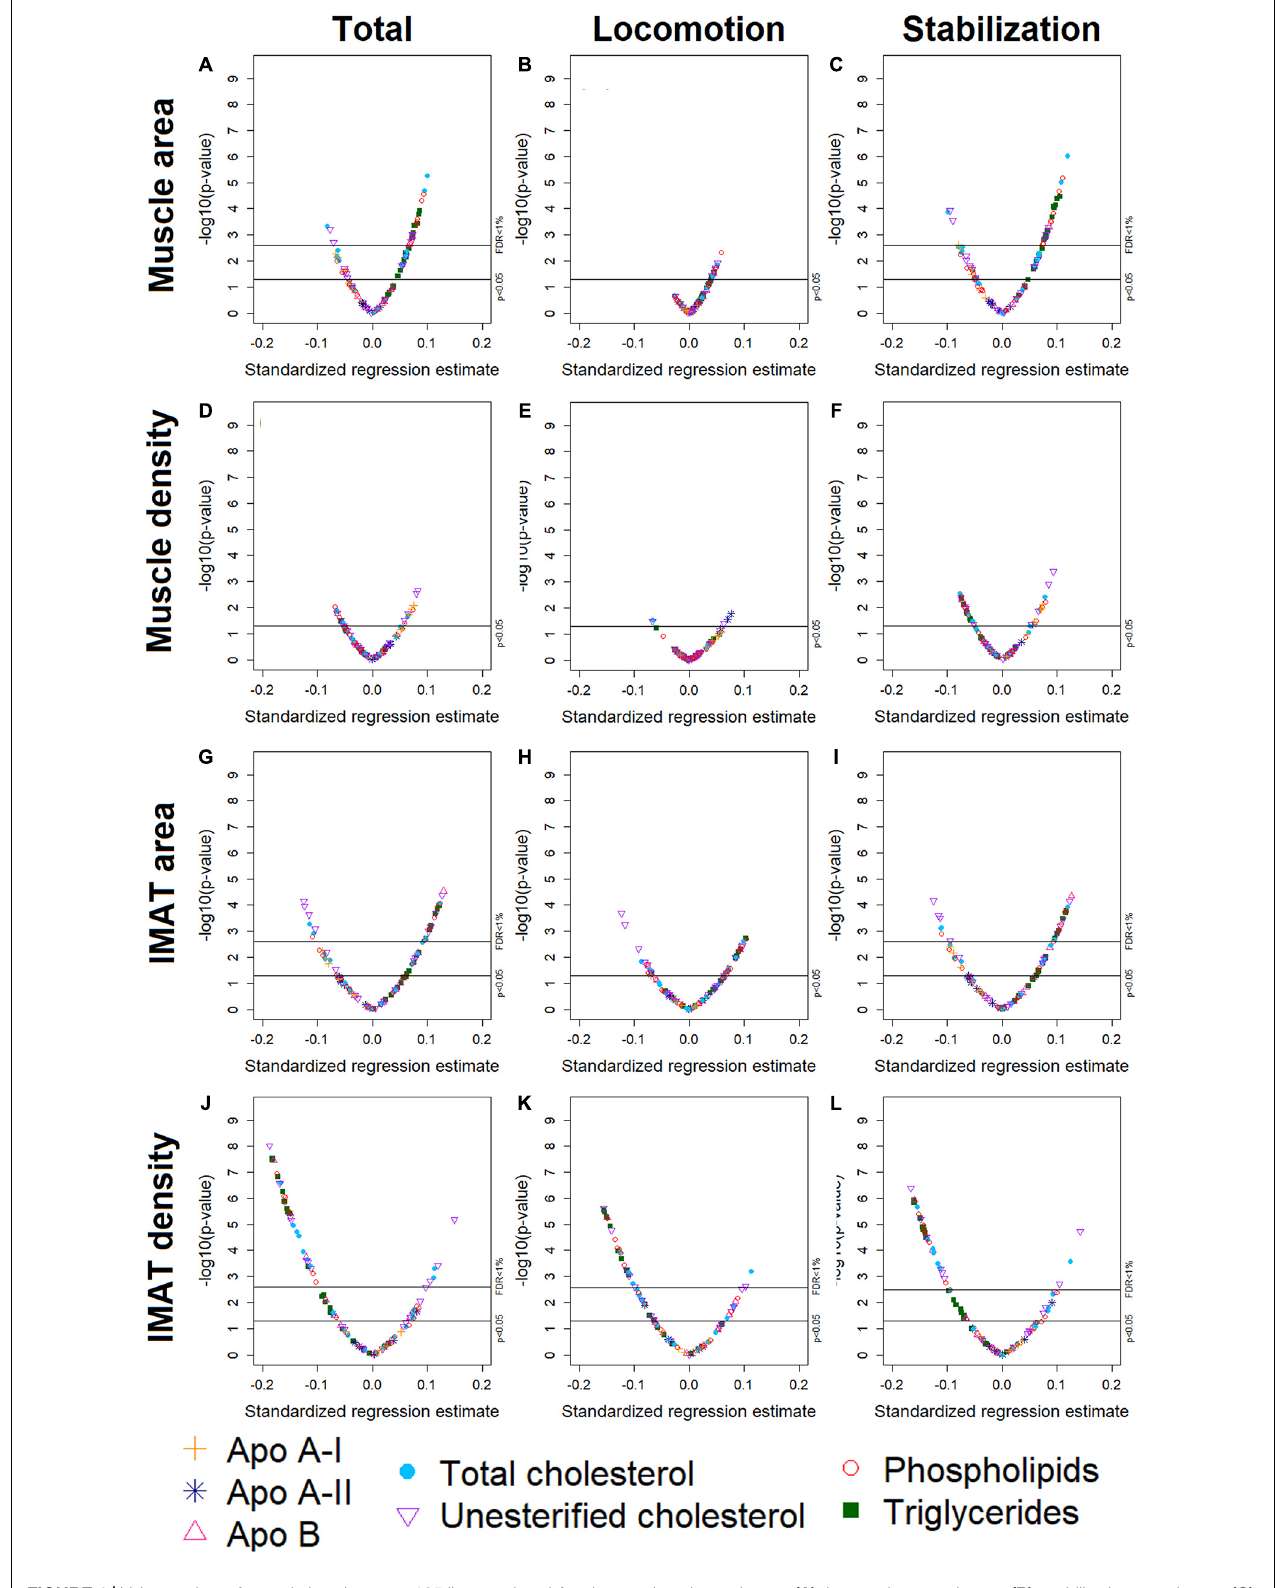
FIGURE 1 | Volcano plots of associations between 105 lipoprotein subfractions and total muscle area (A) , locomotion muscle area (B) , stabilization muscle area (C) , total muscle density (D) , locomotion muscle density (E) , stabilization muscle density (F) , total IMAT area (G) , locomotion IMAT area (H) , stabilization IMAT area (I) , total IMAT density (J) , locomotion IMAT density (K) , and stabilization IMAT density (L) among 947 MESA participants.